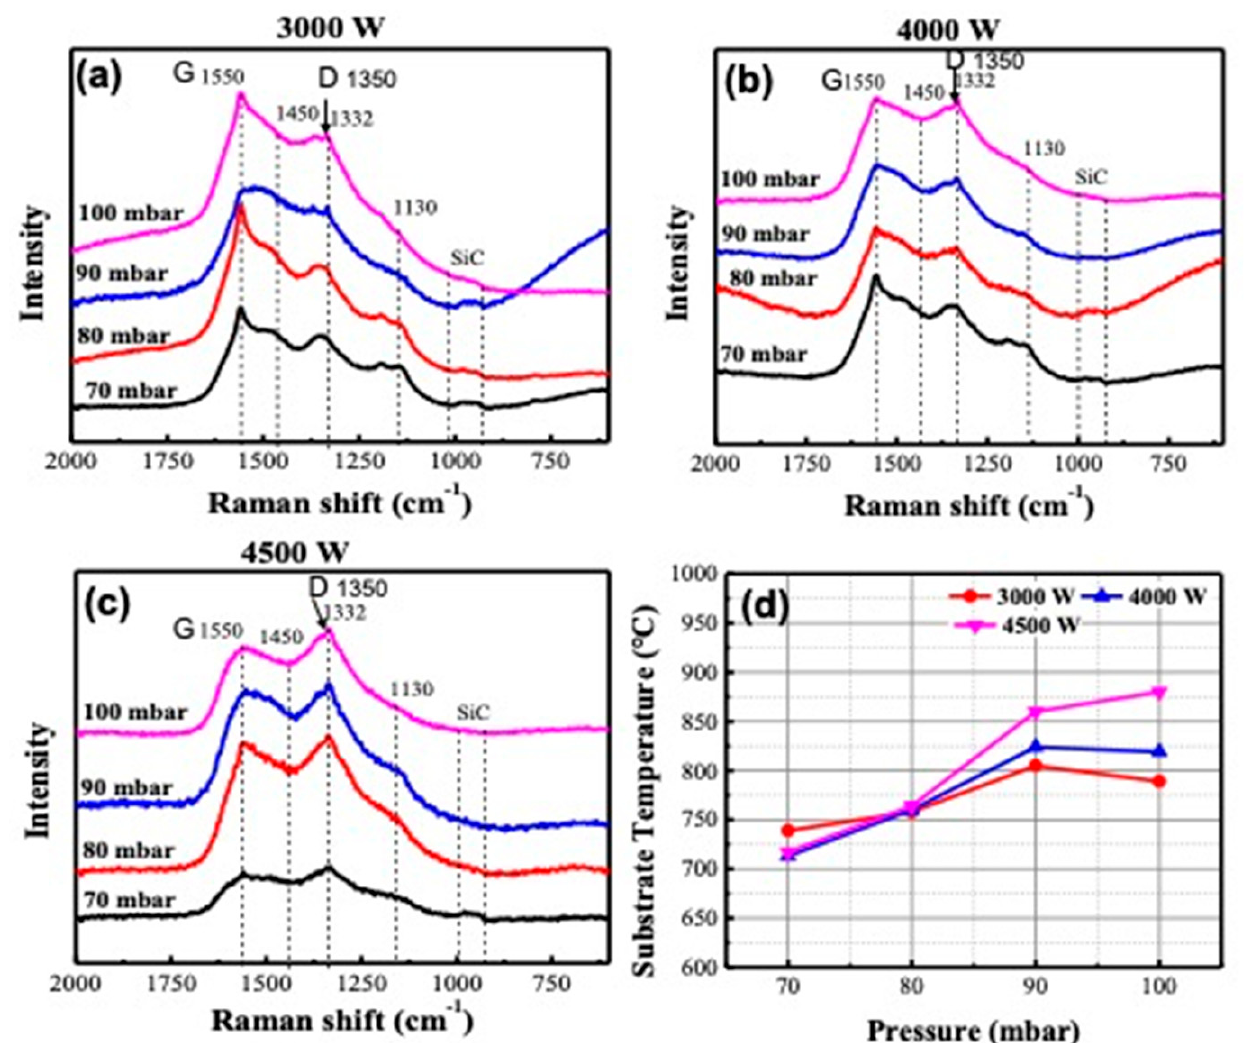
Figure 4. Raman spectra of N-UNCD films grown at: ( a ) 3000 W (70–100 mbar); ( b ) 4000 W (70–100 mbar); ( c ) 4500 W (70–100 mbar); ( d ) Graph of the substrate temperature vs. film grown pressure.